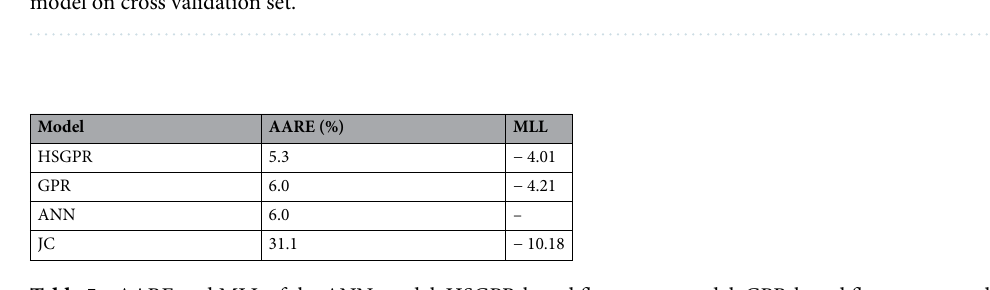
Table 5. AARE and MLL of the ANN model, HSGPR-based flow stress model, GPR-based flow stress model and JC model on the whole dataset.